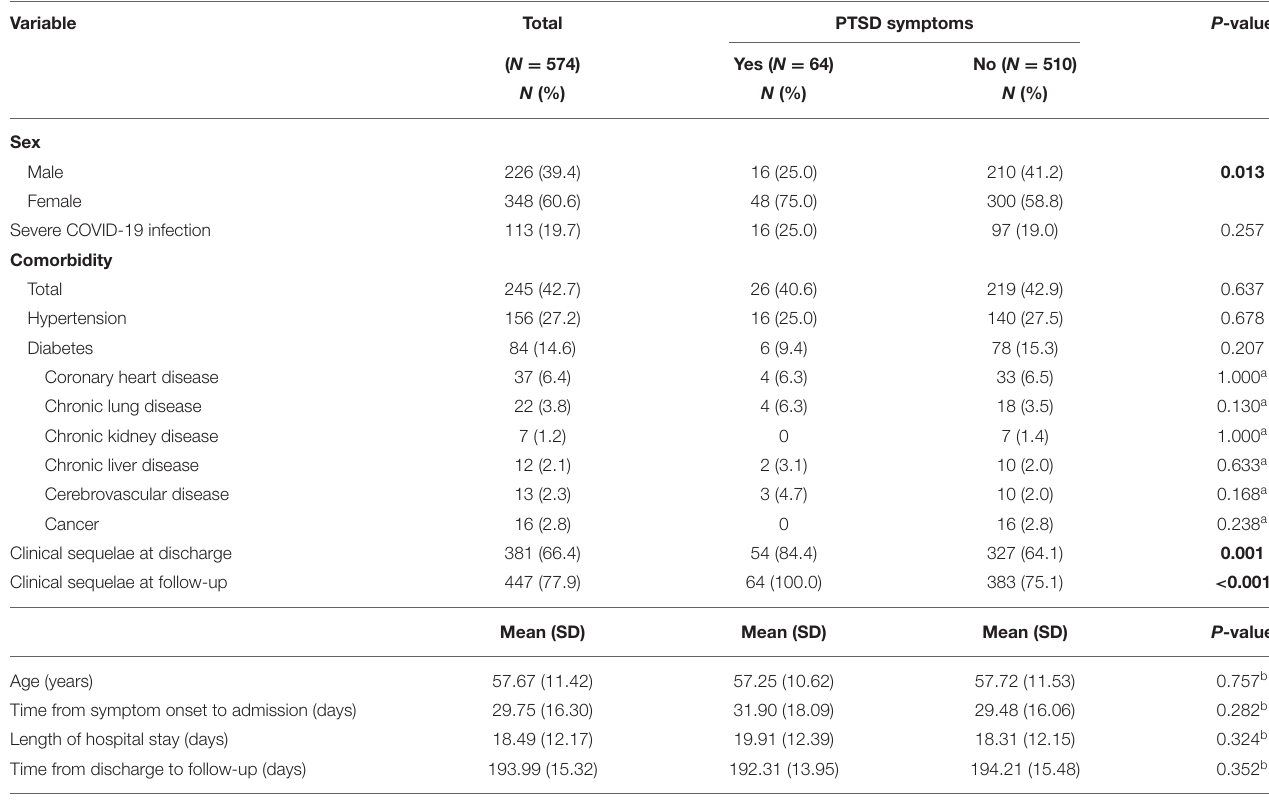
TABLE 1 | Demographic and clinical characteristics of the whole sample and PTSD subgroups.